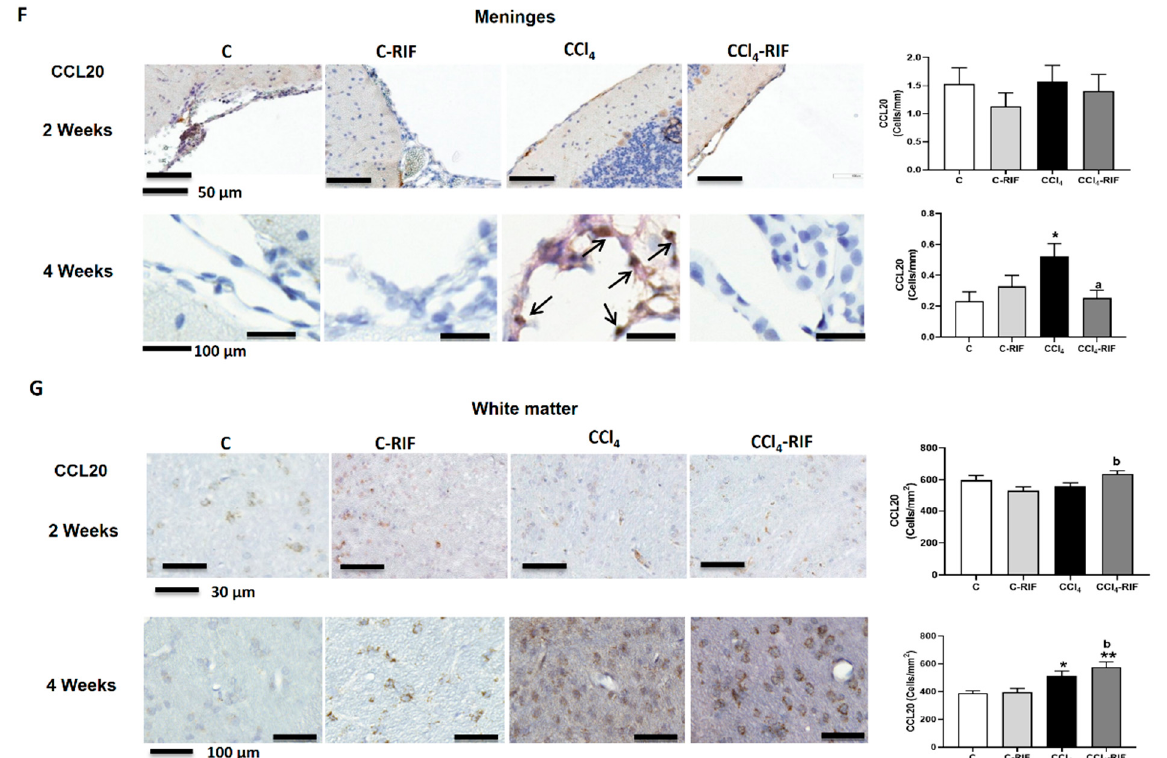
Figure 6. Mild liver damage induces the expression of CCL2, CX3CL1, and CCL20 in cerebellum. ( A ) Western blot analysis of CCL2 content at 2 and 4 weeks. Values are mean ± SEM of 9 rats per group. One-way ANOVA with Tukey’s test (F(3,13) = 9.998, p < 0.0001 for 4 weeks) ( B , C ) Representative IHQ images and analysis of CCL2 expression in Purkinje cells ( B ) and molecular layer at 4 weeks ( C ). Values are mean ± SEM of 3 rats per group. One-way ANOVA with Tukey’s test for Purkinje cells (F(3,13) = 9.998, p < 0.0001) and Welch’s ANOVA with Dunnett’s test for molecular layer (W(3,17) = 19.53, p < 0.0001) were performed to compare all groups. ( D , E ) Representative images of CX3CL1 expression in meninges and white matter and quantification at 4 weeks. Values are mean ± SEM of 5 rats per group. One-way ANOVA with Tukey’s test for white matter (F(3,18) = 5.063, p < 0.01) and nonparametric Kruskal–Wallis with Dunn’s test (K-W(4,21) = 11.48, p < 0.01) were performed to compare all groups. ( F , G ) Representative images of CCL20 expression in meninges (F) and white matter (G ) and quantification at 4 weeks. Values are mean ± SEM of 4–5 rats per group. Welch’s ANOVA test with Dunnett’s test for white matter (W(3,14) = 8.261, p = 0.001) and nonparametric Kruskal–Wallis with Dunn’s test for meninges (K-W(4,11) = 9.412, p < 0.05) were performed to compare all groups. Values significantly different from control rats are indicated by asterisks, from CCl 4 rats by a, and from C-RIF rats by b. * p < 0.05, ** p < 0.01, *** p < 0.001, **** p < 0.0001, a p < 0.05, aa p < 0.01, aaaa p < 0.0001, b p < 0.05.